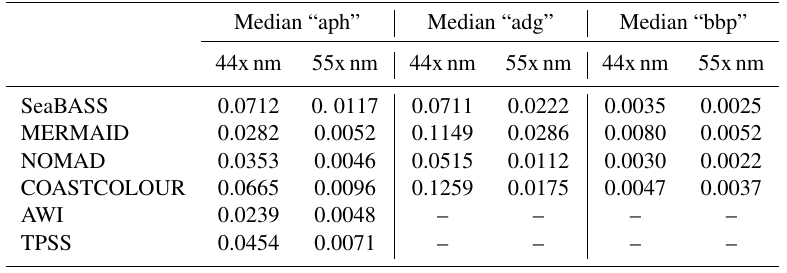
Table 3. Summary of median values for “aph”, “adg”, and “bbp” at 44X and 55Xnm for each data set (as shown in Fig. 12a–f). Data were first searched at 445 and 555nm, and then with a search window up to 8nm, to include data at 547nm.